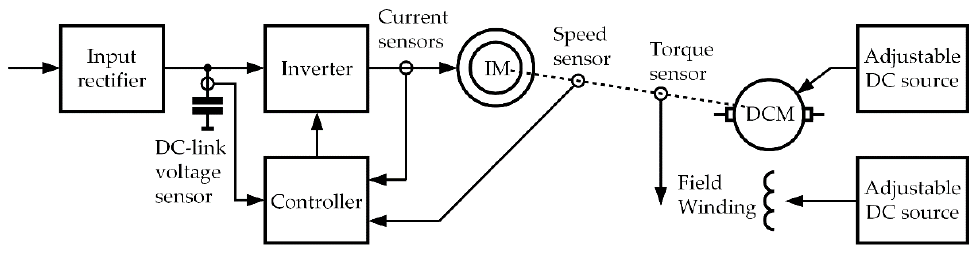
Figure 3. Test bench block scheme.